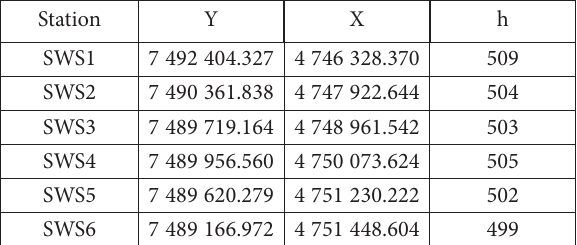
Table 1. Location of monitoring stations (SWS – Surface Water Samples) based in field measurements (GPS)